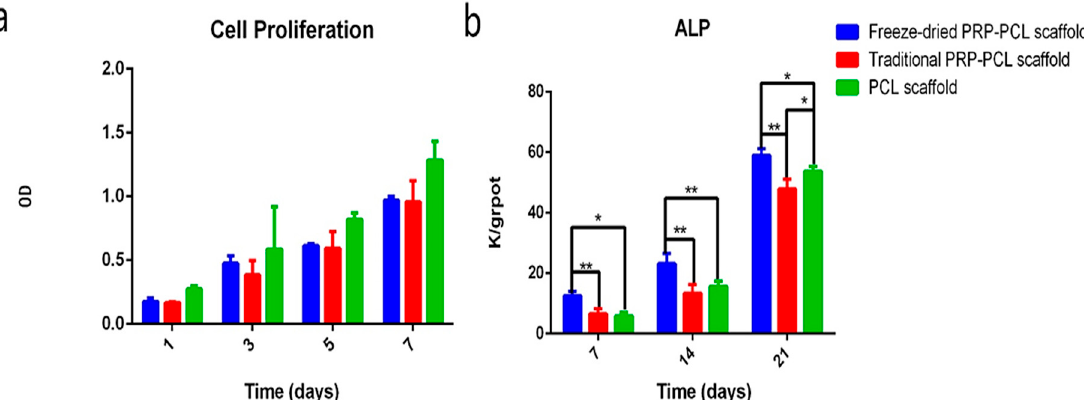
Figure 6. ( a ) Cell proliferation on the freeze-dried PRP-PCL scaffolds, traditional PRP-PCL scaffolds and bare PCL scaffolds 1, 3, 5, and 7 days after seeding; ( b ) ALP activity of the freeze-dried PRP-PCL scaffolds, traditional PRP-PCL scaffolds and bare PCL scaffolds seven and 14 days after seeding (* p < 0.05, ** p < 0.01).